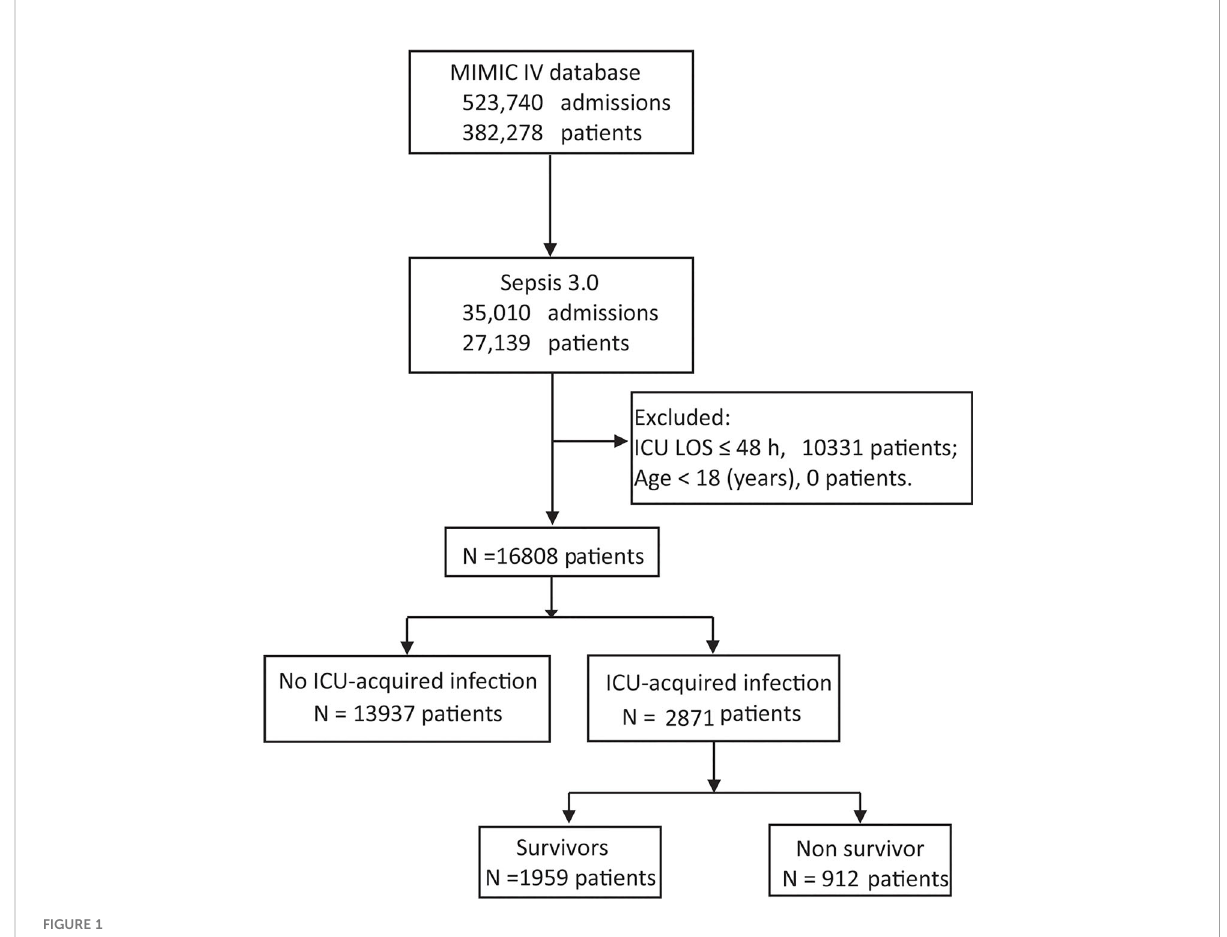
FIGURE 1 Study design fl